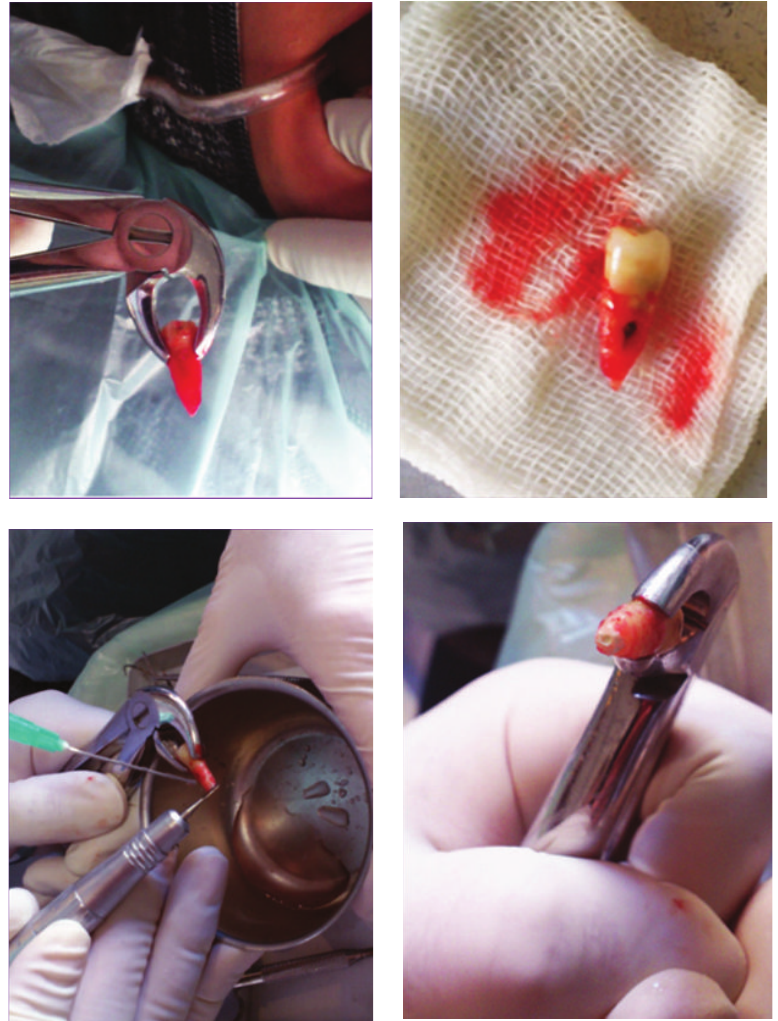
Figure 4: After the tooth extraction, apical 3 mm of the root apex was resected and the root end cavity was prepared and filled with CEM